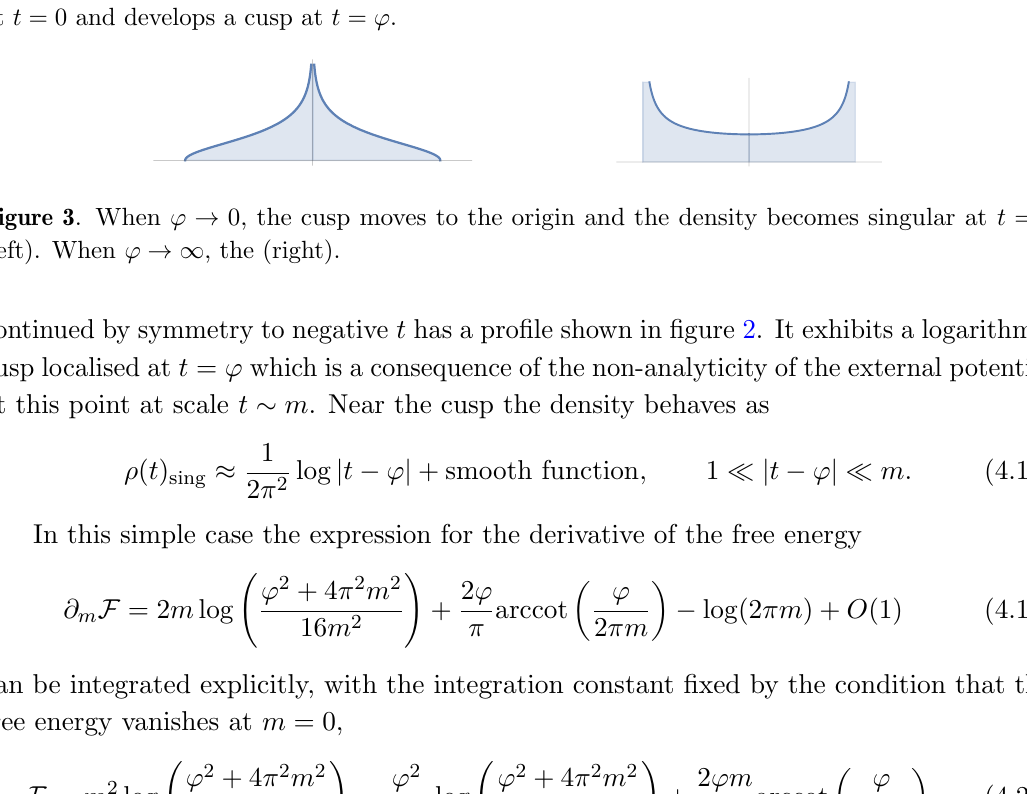
Figure 2 . Pro(cid:12)le of the spectral density for a large square (cid:12)shnet with σ = 0 . The density is (cid:12)nite at t = 0 and develops a cusp at t = ϕ .